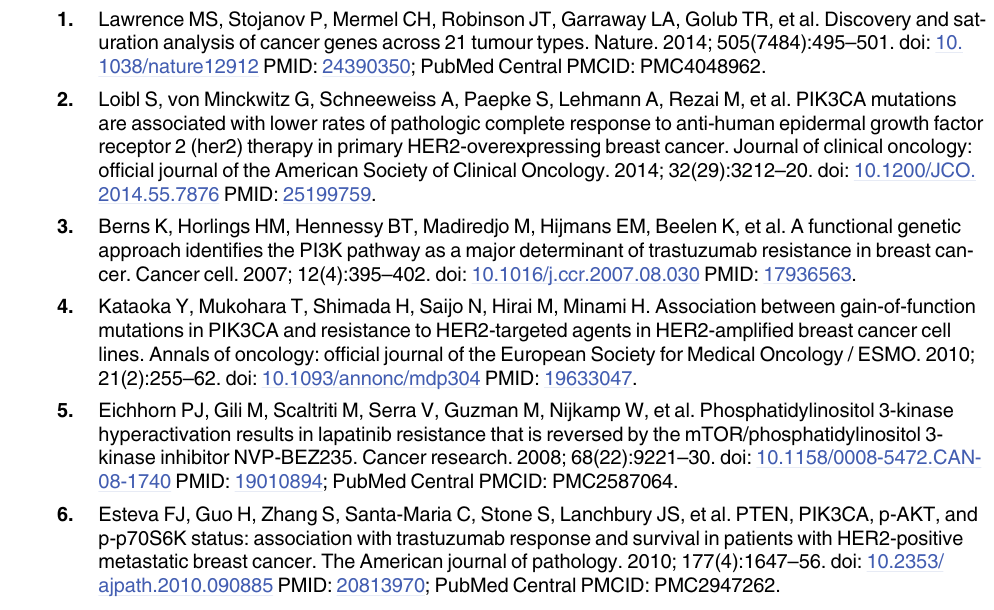
S4 Fig. Paired forest plot depiction of empirical Bayes predicted versus observed sensitivity and